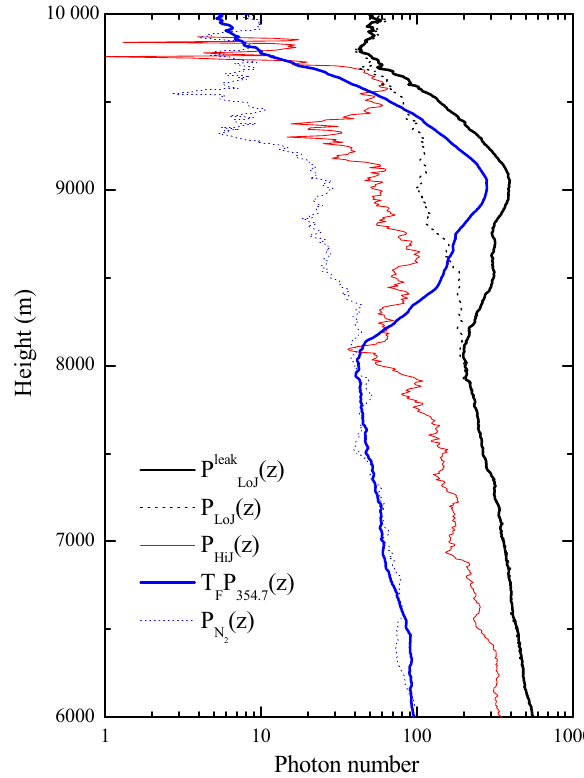
Figure 3. Vertical profiles of P LoJ (z) , P HiJ (z) , T F P 354 . 7 (z) and P synt (z) for the time interval 13:38–13:46UTC on 20 April 2013, LoJ revealing the presence of high cirrus clouds extending between 7.9 and